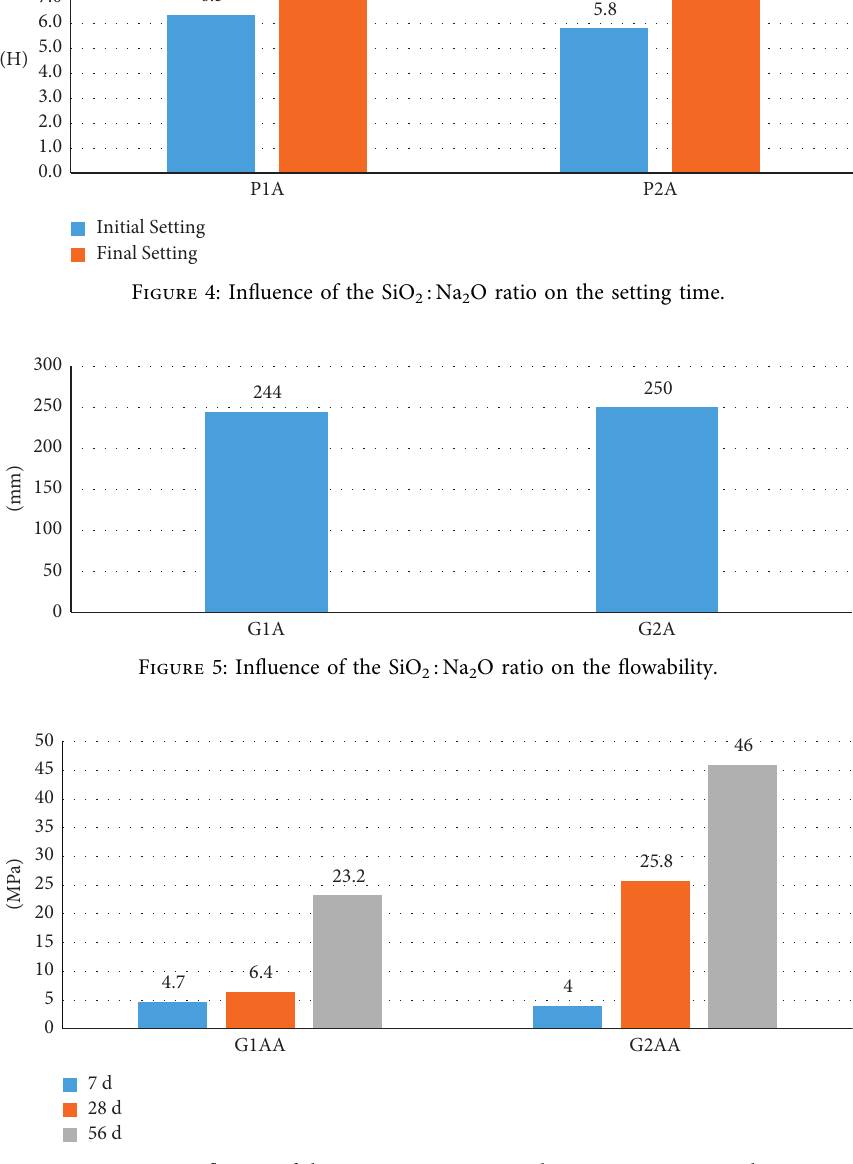
Figure 6: Influence of the SiO 2 :Na 2 O ratio on the compressive strength.